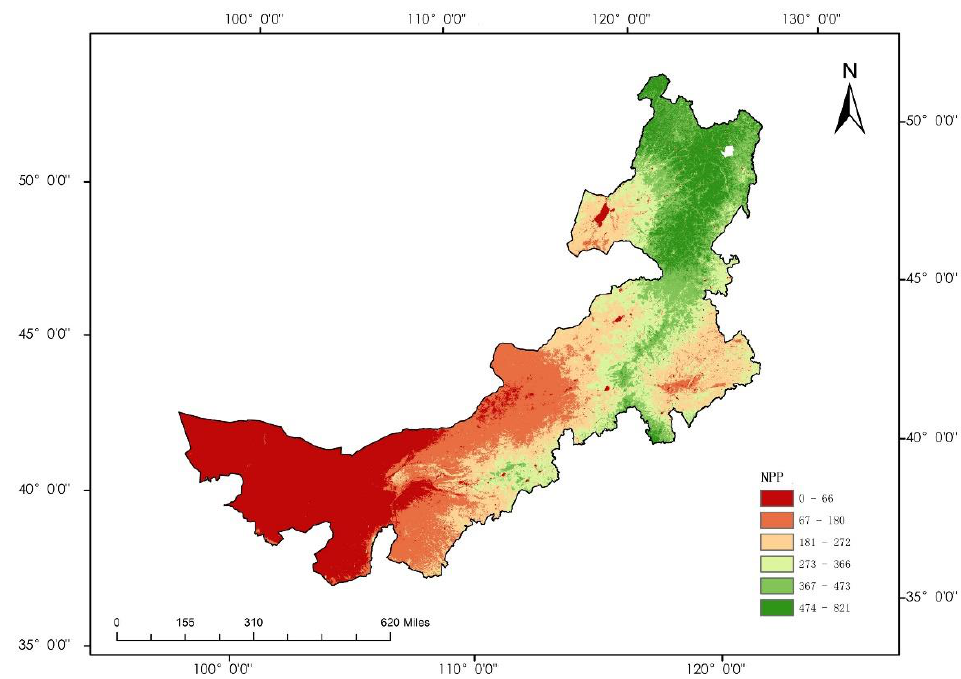
Figure 13. NPP spatial distribution.